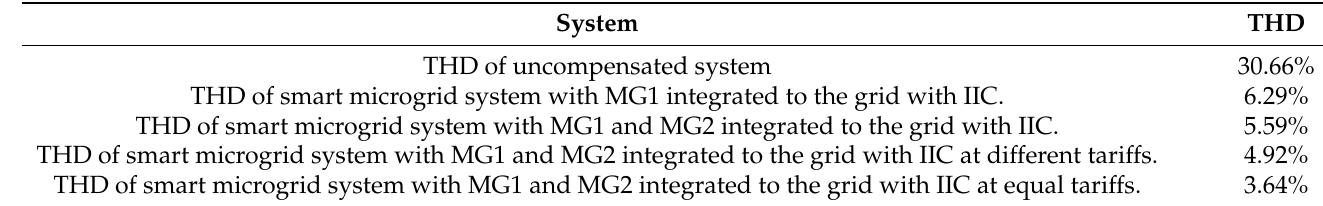
Figure 21. FFT analysis after compensation of microgrids ( a ) at different tariff condition and ( b ) at equal tariff condition. Table 5. THD of smart microgrid system for different